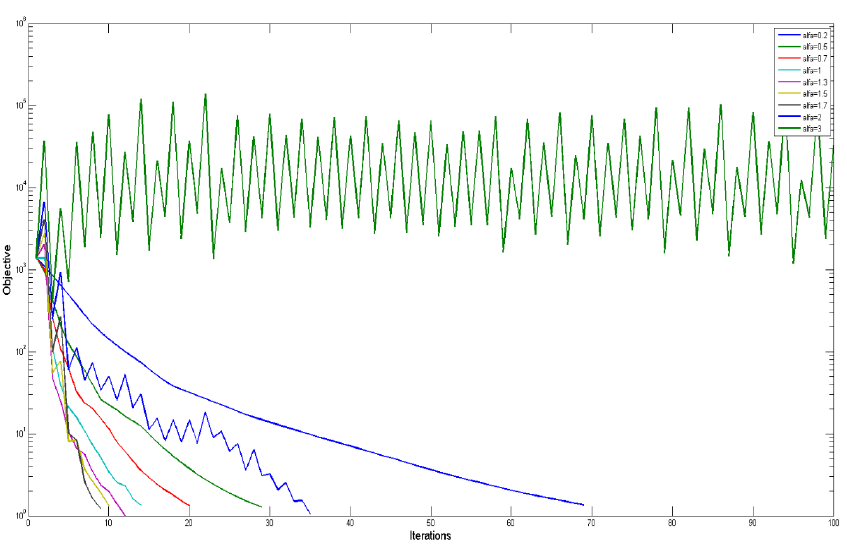
Figure 12—Objective function behavior with iteration numbers for different